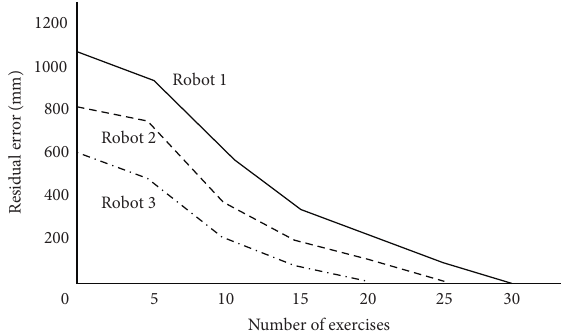
Figure 7: Control error test of the encoder-based control method.